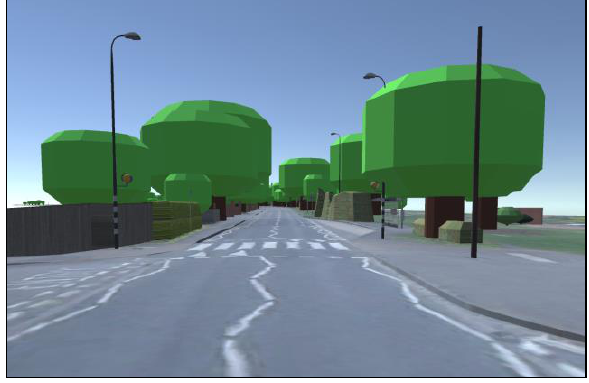
Figure 3: A view of part of the 3D model showing a zebra crossing, hedges, trees and